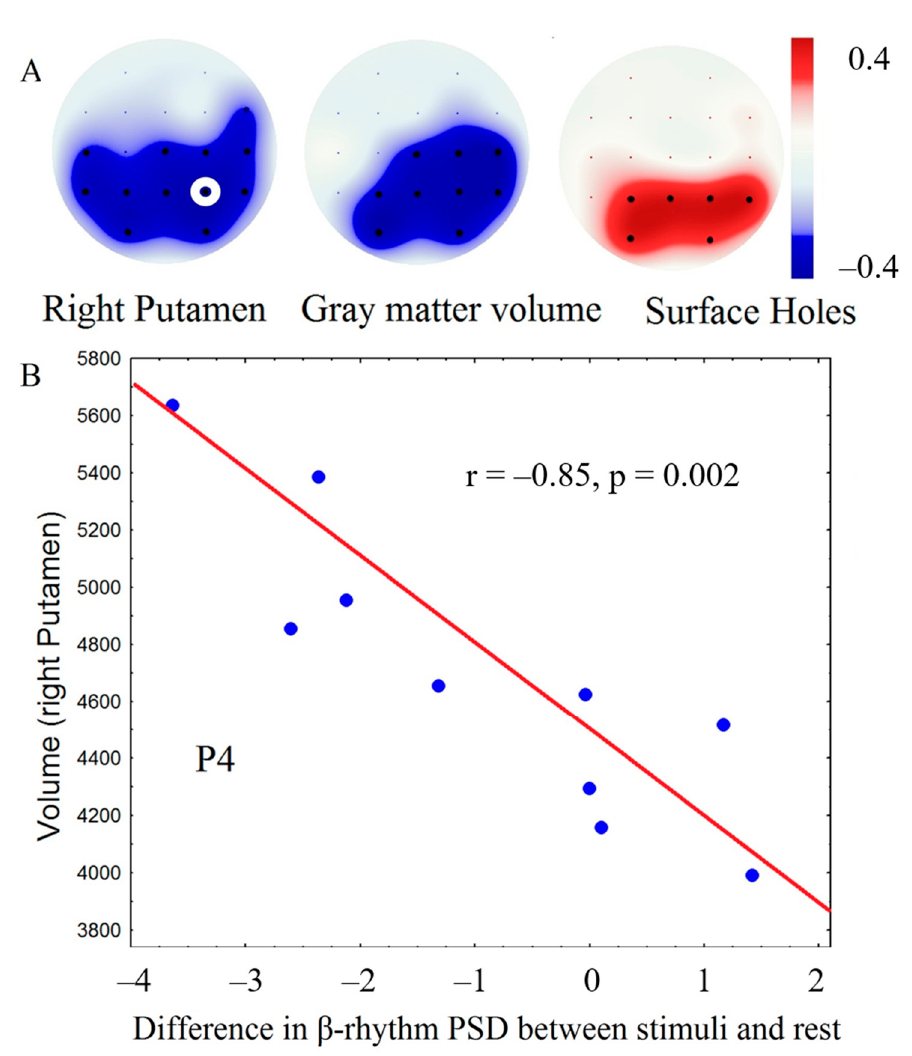
Figure 5. Results of clustering permutation’s correlation analysis between the volume of brain structures and average decrease of theta rhythm power during tactile stimulation compared to rest. A : maps of significant correlations (black dots—electrodes showing significant correlations after Bonferroni correction); B : scatterplot showing a relation between electroencephalography (EEG) spectral power at the electrode marked by a white circle and brain volume (x—di ff erence between theta rhythm PSD during tactile stimulation compared to rest, y—volume in voxels), blue dots—individual values.